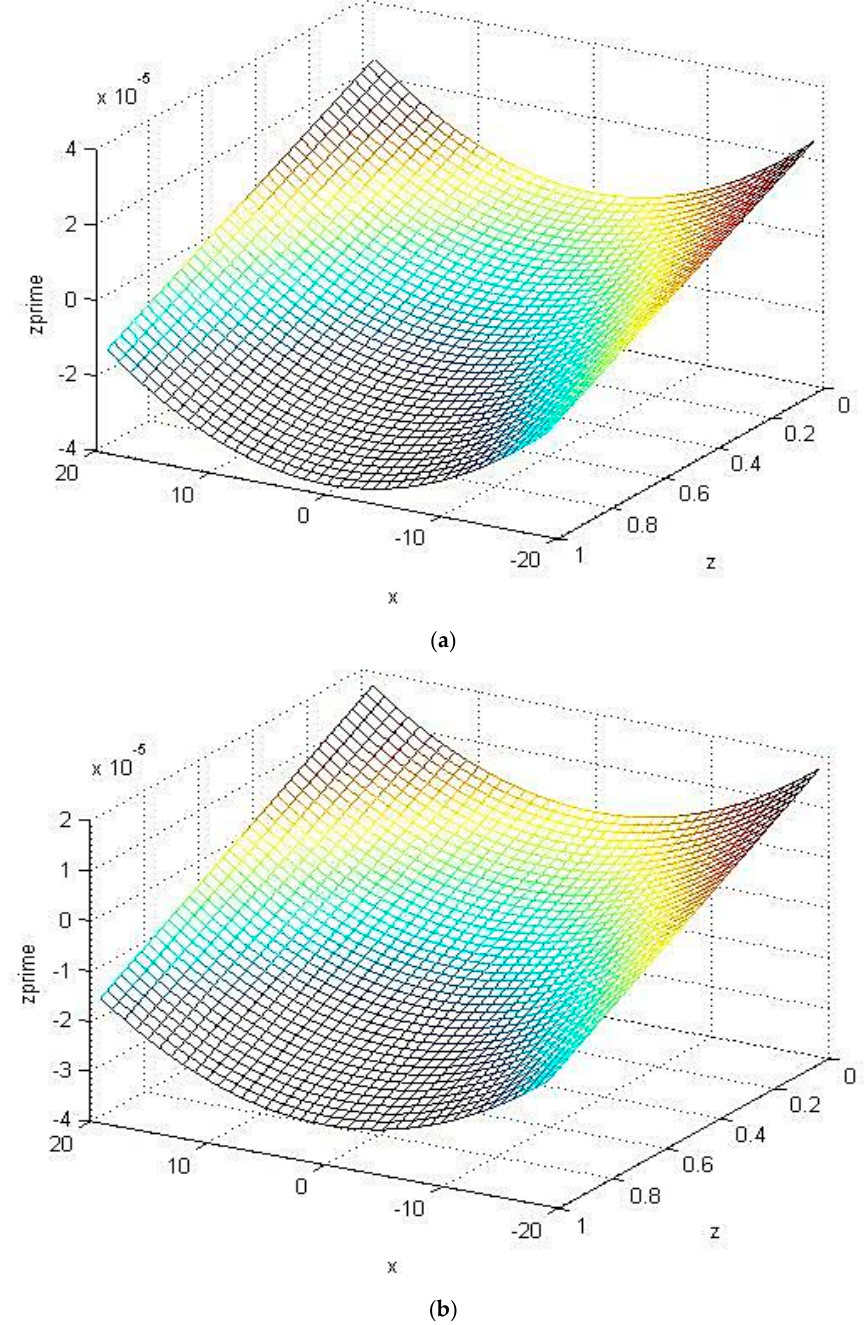
Figure 14. Longitudinal deformation of the microstructure with unequal surface curvature radius. ( a ) Comprehensive deformation (Radius: 25 mm); ( b ) comprehensive deformation (Radius: 30 mm).